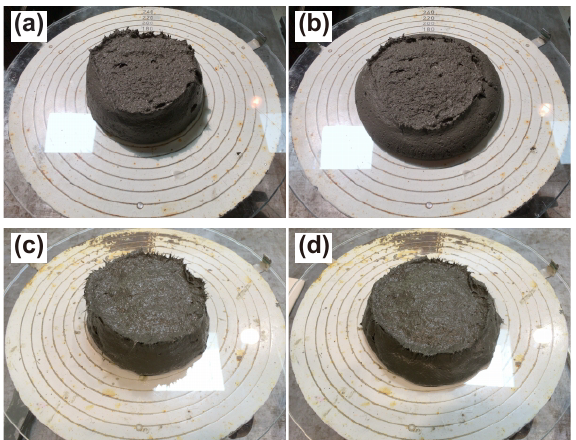
Figure 5. Selected results of the flow table tests ( a ) before and ( b ) after shocks for Mixture A as well as ( c ) before and ( d ) after shocks for Mixture C.